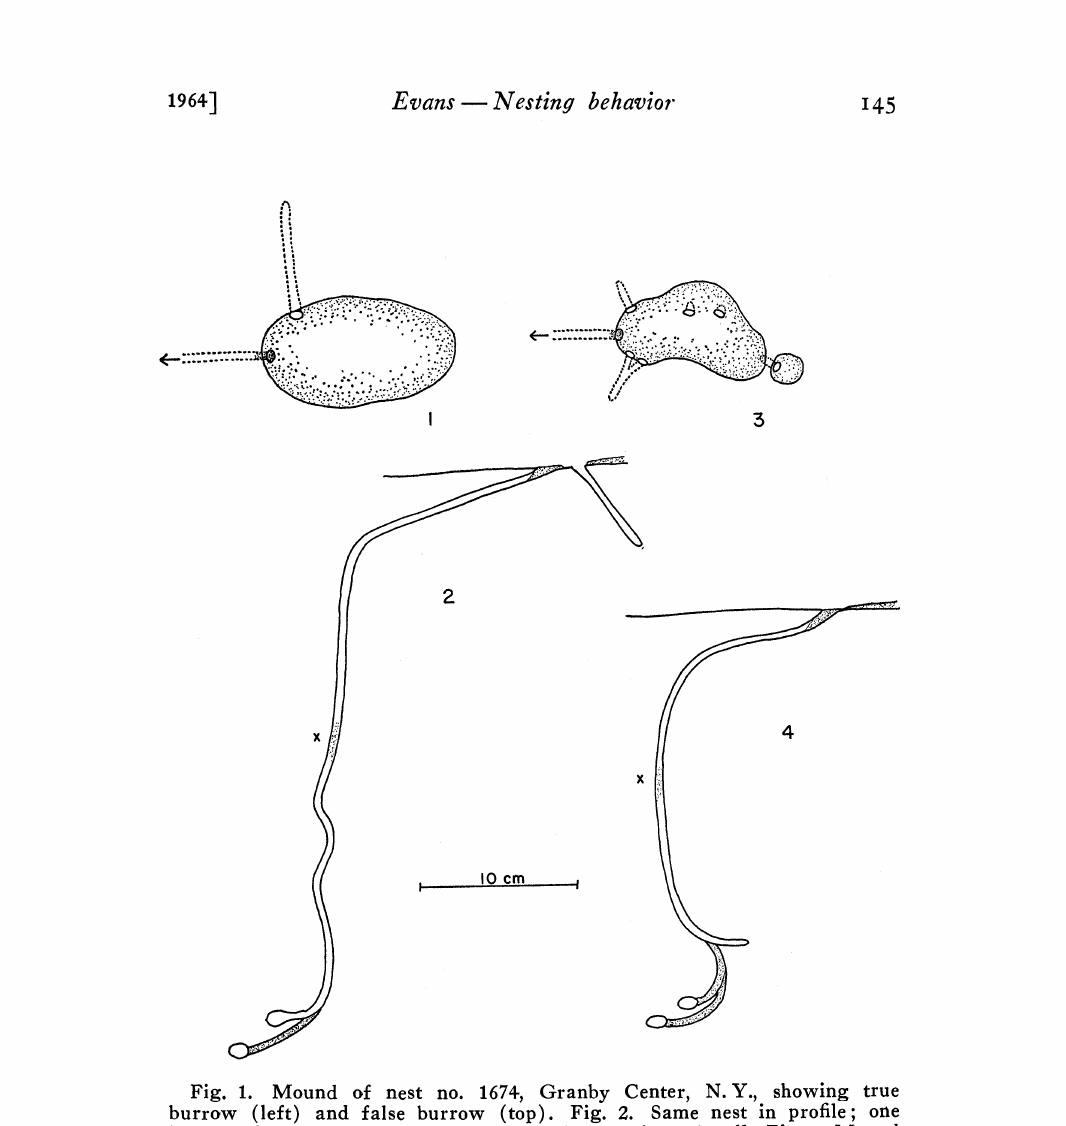
Fig. 1. Mound of nest no. 1674, Granby Center, N.Y., showing true burrow (left) and false burrow (top). Fig. 2. Same nest in profile; one bee was found in the burrow at x, several o.thers in each cell. Fig. 3. Mound of nest no. 1848-3, Lexington, Mass., showing five false burr.ows, one with a double entrance. Fig. 4. Nest no. 1846, Lexington, Mass., in profile; eight bees were found in the burrow at x, several others in each cell; the false burrow was destroyed accidentally and hence is not shown